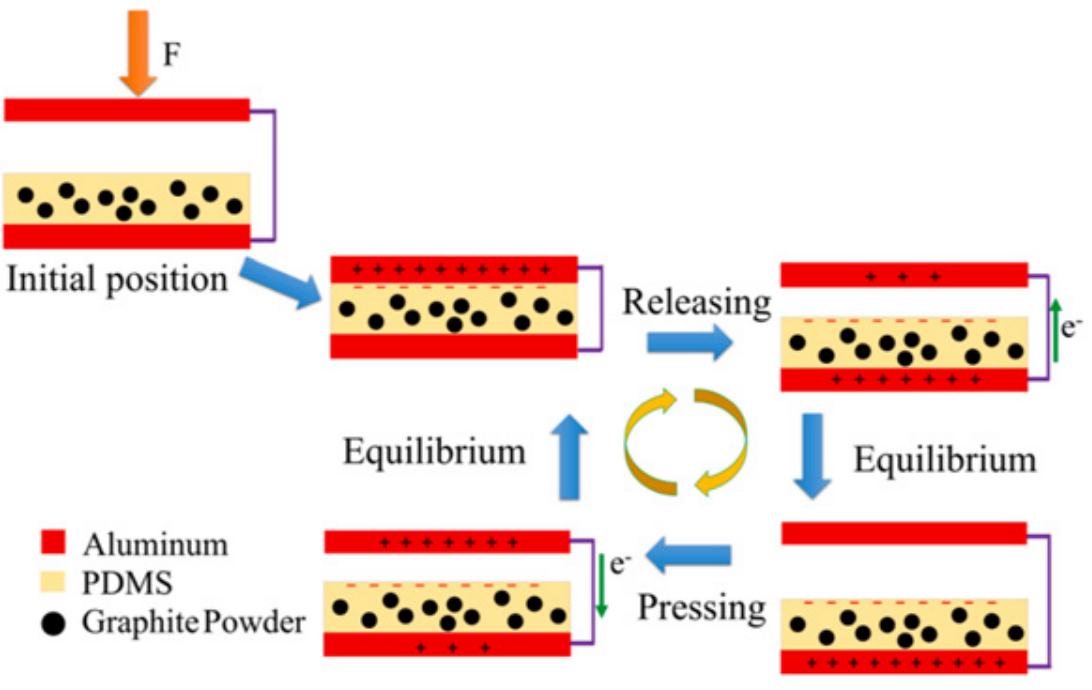
Figure 20. The working principle of TENG from contact and separation mode [129].